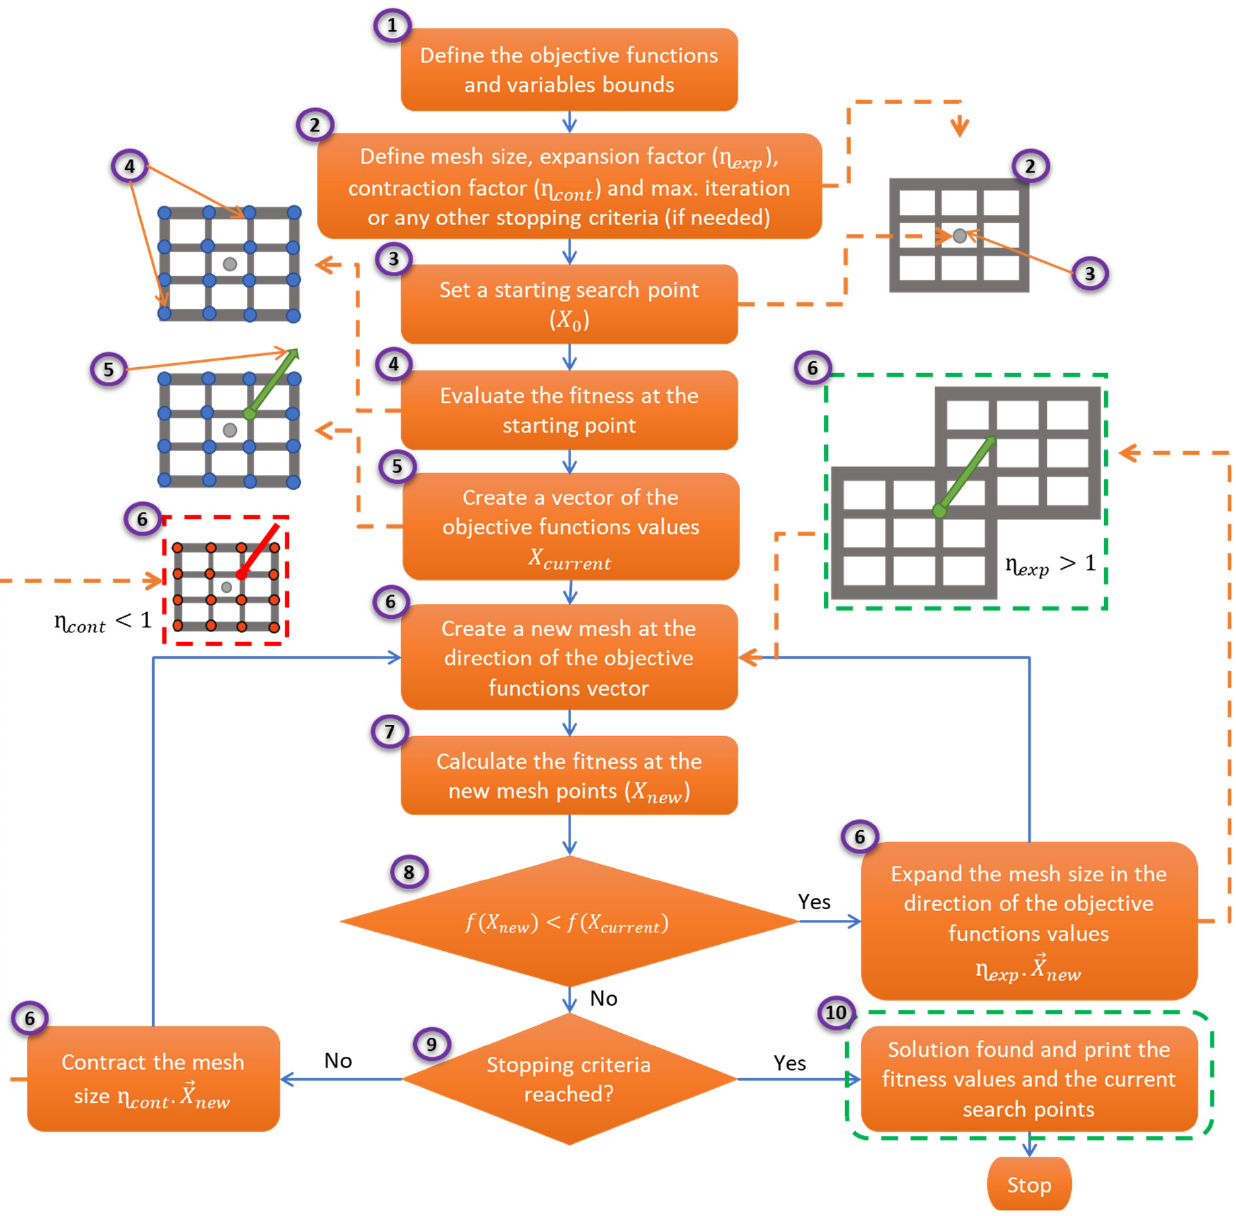
Figure 9. Flowchart of MOPSA algorithm.